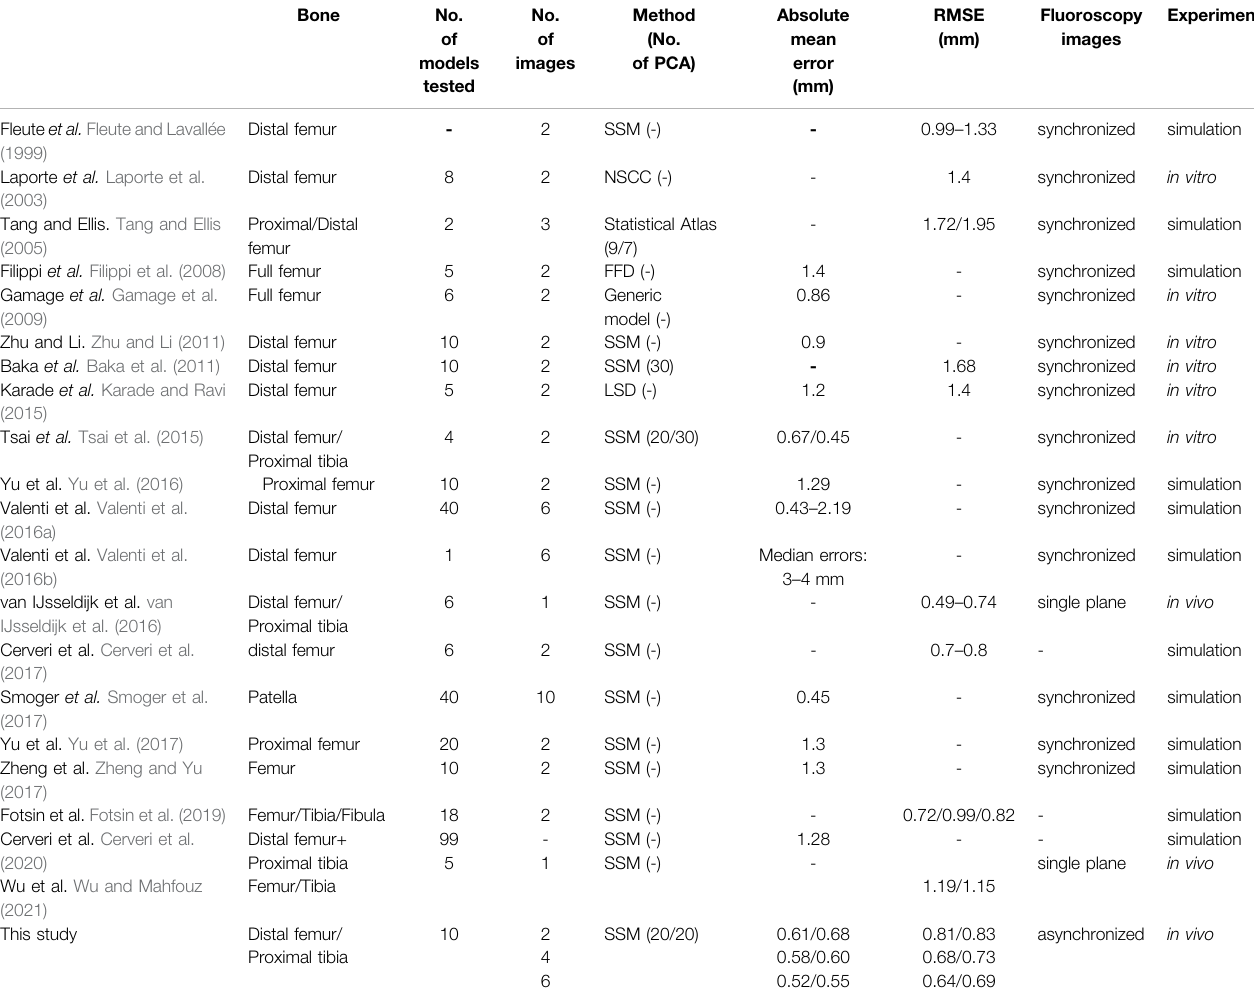
TABLE 3 | Comparisons of the bone type, number of reconstructed models, number of fl uoroscopy images, methods of modeling (number of PCA if using SSM), absolute mean errors, RMSE, image synchronization, and the experiment type for 3D knee shape reconstruction between published studies and the current